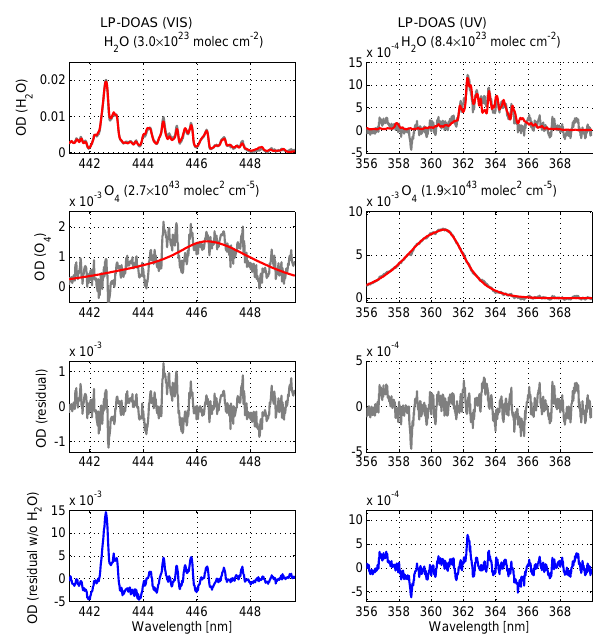
Figure 3. A LP-DOAS-fit result for the fitting intervals around 363 and 442nm. The spectra were recorded on 29 August 2015 between 20:58 and 21:45UTC. Top left panel: at 442nm the H 2 O dSCD ( 3 . 0 ± 0 . 04 ) × 10 23 moleccm − 2 (O 4 dSCD ( 2 . 7 ± 0 . 6 ) × 10 43 molec 2 cm − 5 ). Top right panel: at 360nm the H 2 O dSCD ( 8 . 4 ± 0 . 6 ) × 10 23 moleccm − 2 (O 4 dSCD ( 1 . 85 ± 0 . 03 ) × 10 43 molec 2 cm − 5 ).